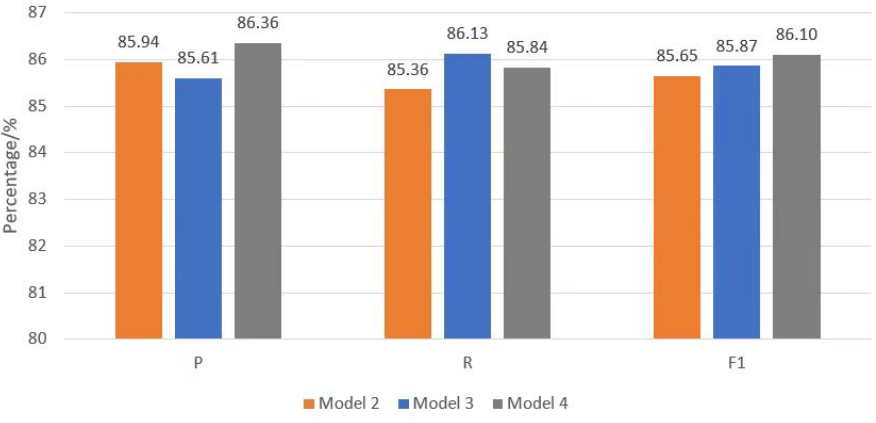
Figure 5. The performance statistics of the improved semi-supervised learning algorithm model.